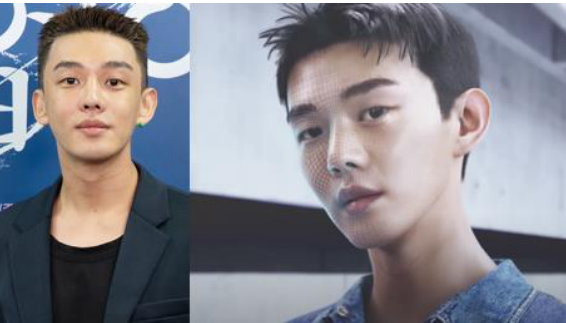
Figure 3. You, Ah-in. (L—Human, R—Digital Human).